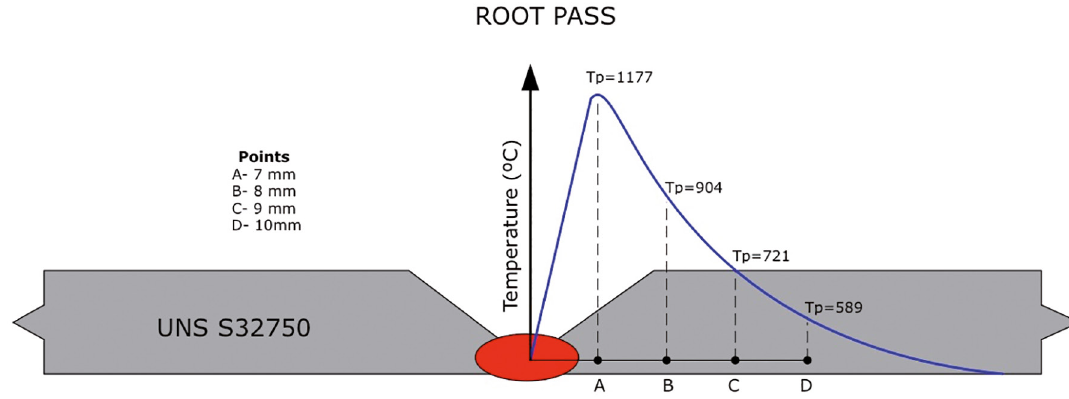
Figure 3. Heat distribution in the root pass of the welding.